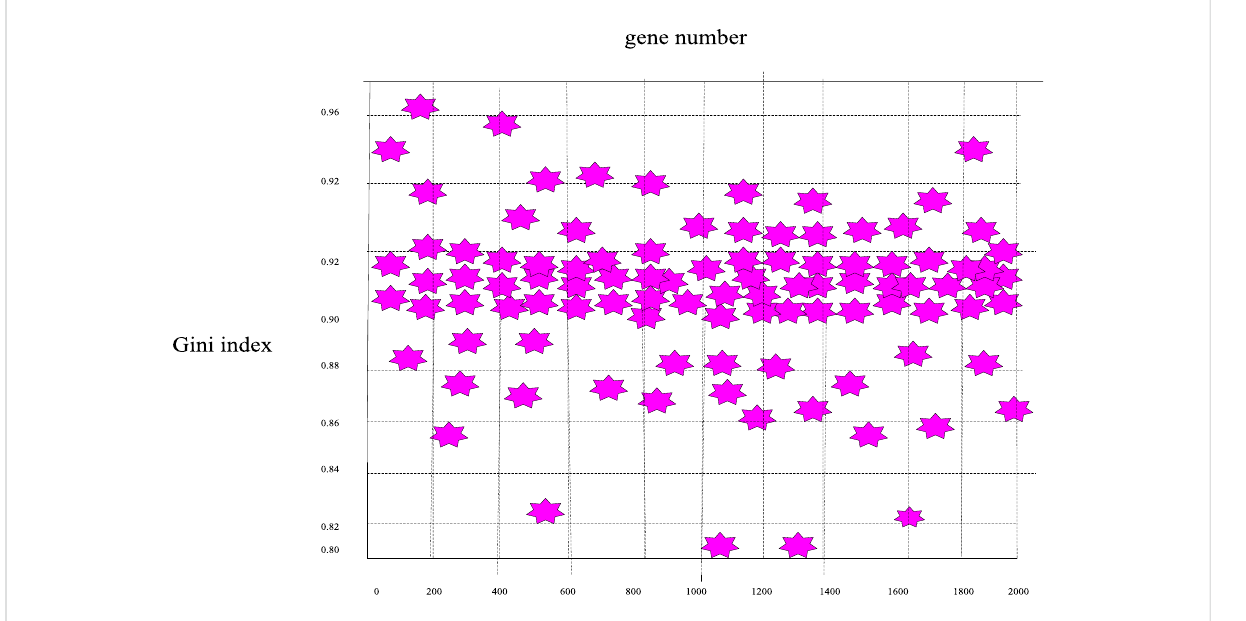
FIGURE 8 Scatter plot of the distribution of Gini index distribution of breast cancer